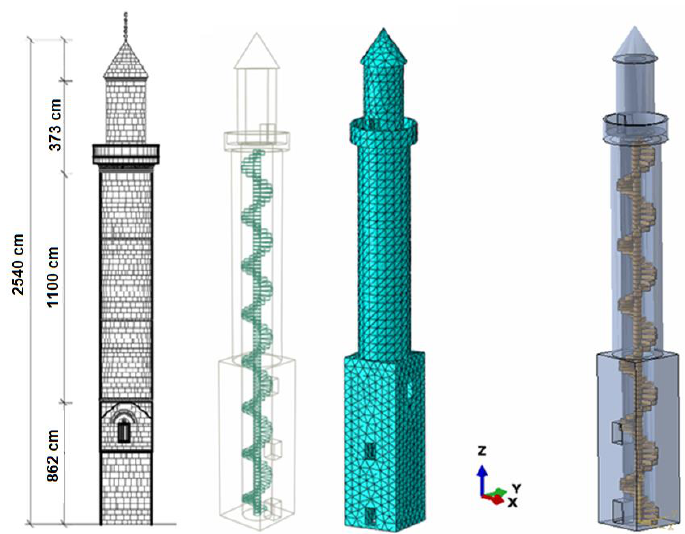
Figure 6. Sample minaret dimensions and 3D models (H = 25.40 m).